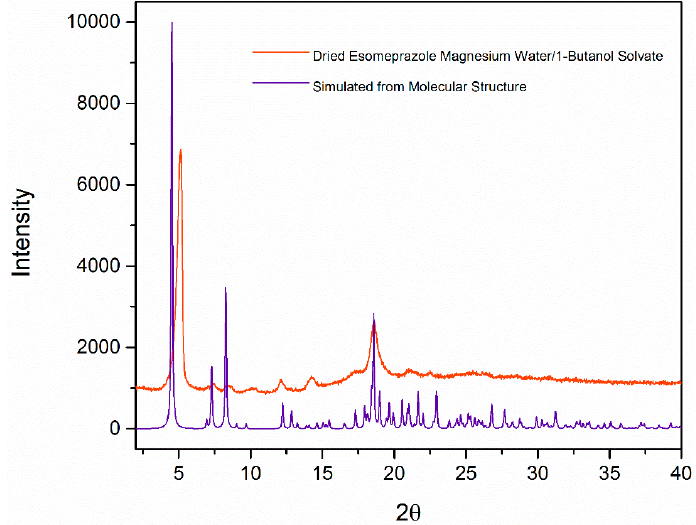
Figure 6. X-ray powder diffraction of esomeprazole magnesium water/butanol solvate calculated from single crystal structure and esomeprazole magnesium water/butanol solvate after drying under vacuum.